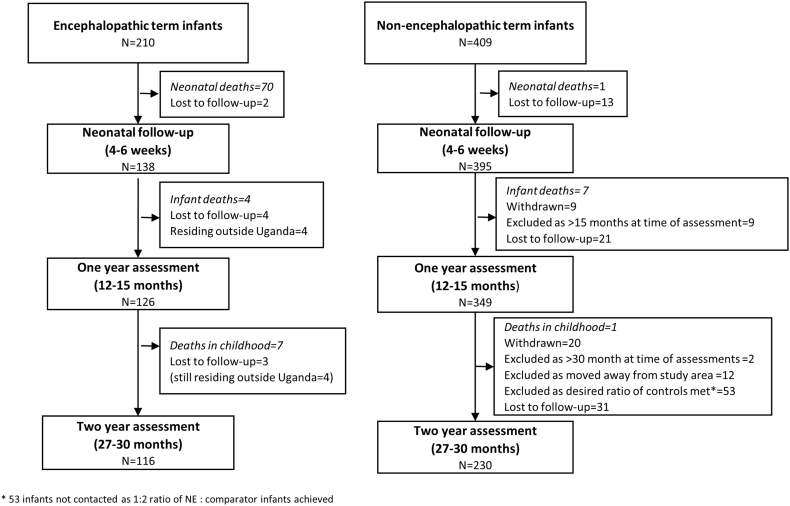
Flow diagram of participants.